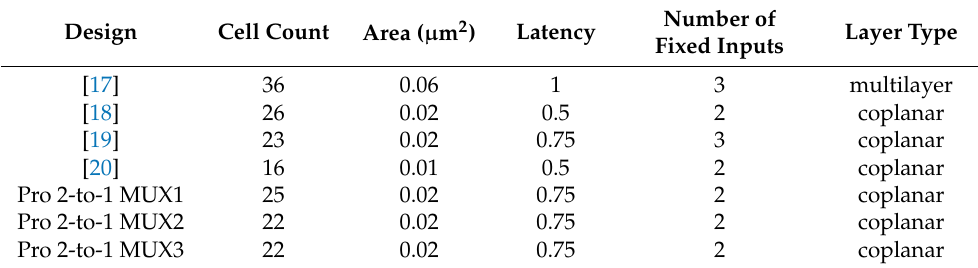
Figure 17. Layouts of the proposed reversible gates. ( a ) the first reversible gate (RG1), ( b ) the second reversible gate (RG2), and ( c ) the third reversible gate implemented by using the XOR in [5] (RG3). Table 6. Comparisons of the performance for alternative 2-to-1